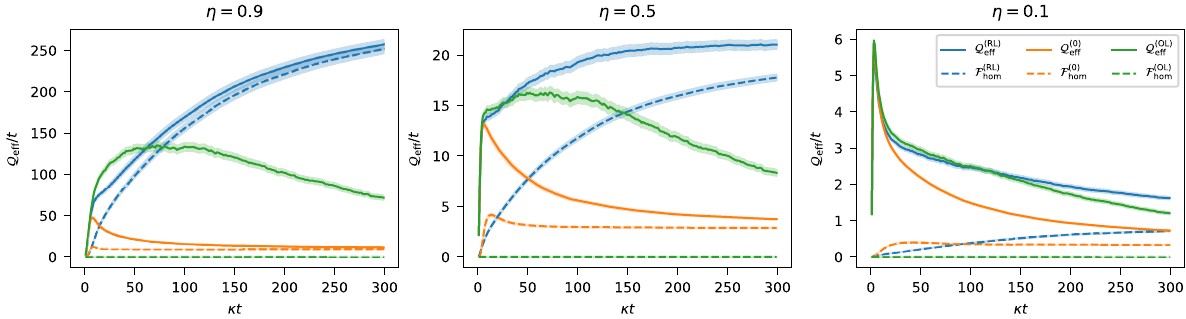
FIG. 7. Performance of the control strategies as a function of time, quantified by the Fisher information divided by time, and for different values of η . All the other parameters are fixed as in Fig.